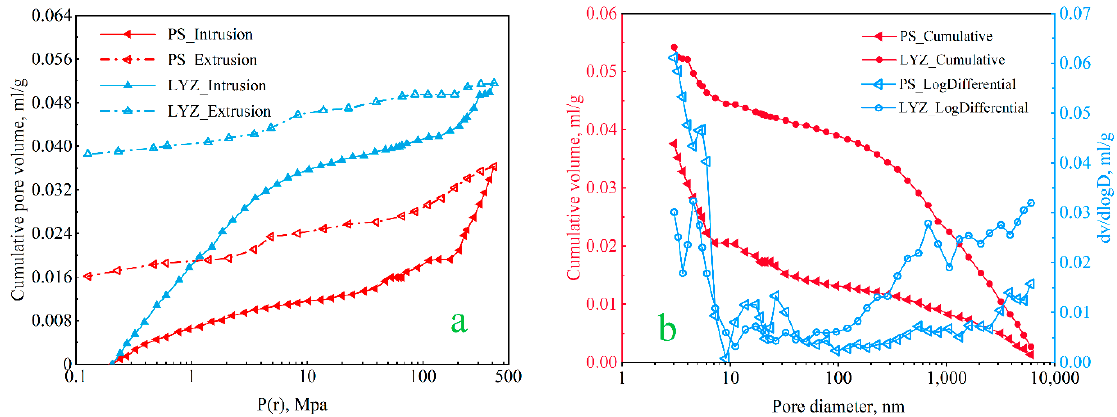
Figure 2. ( a ) Intrusion/extrusion mercury curve of PS and LYZ coal samples, ( b ) Volume distribution of PS and LYZ coal samples. of PS and LYZ coal